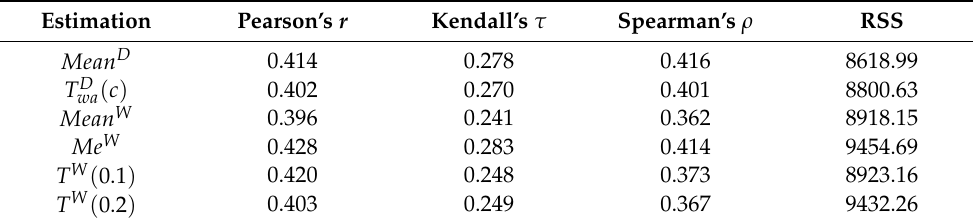
Table 5. Evaluation of models with 111 missing data.